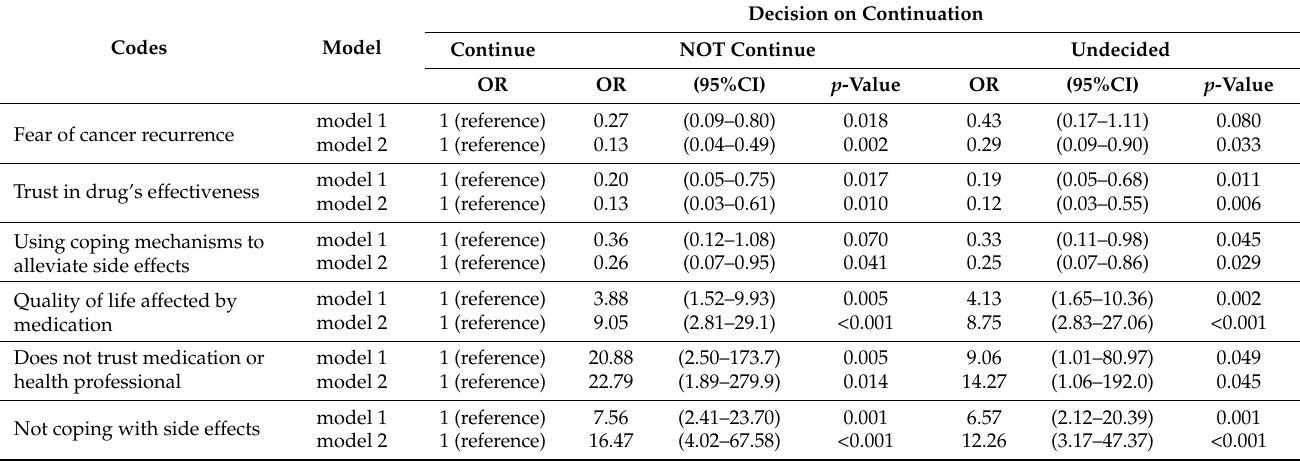
Table 3. Crude and multivariable adjusted association between mentioning of specific codes and decision on treatment continuation (calculated using logistic